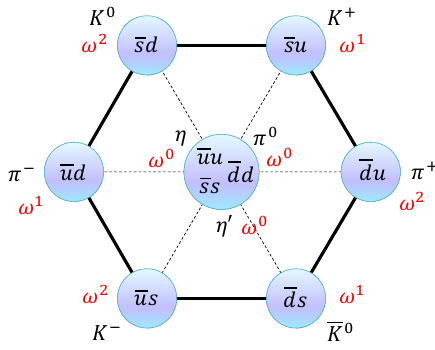
Figure 8 . Grading and quantum distillation in the spin-zero meson octet sector. Grading assigns phases ω k = e i 2 πk